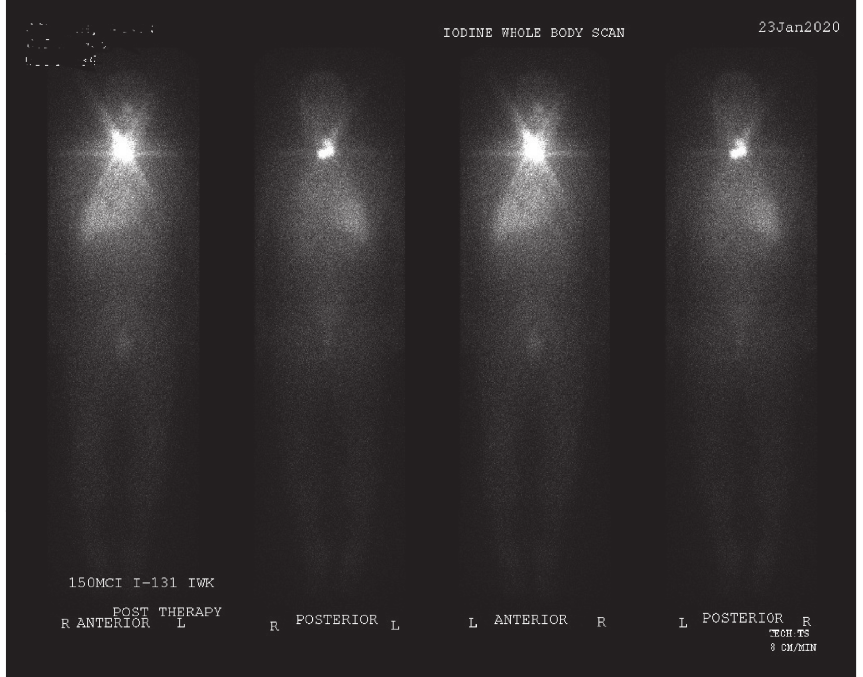
Figure 6: Whole body scan, one week posttreatment with 150mCi I-131. It shows localized uptake in the neck area with no evidence of distant metastasis.